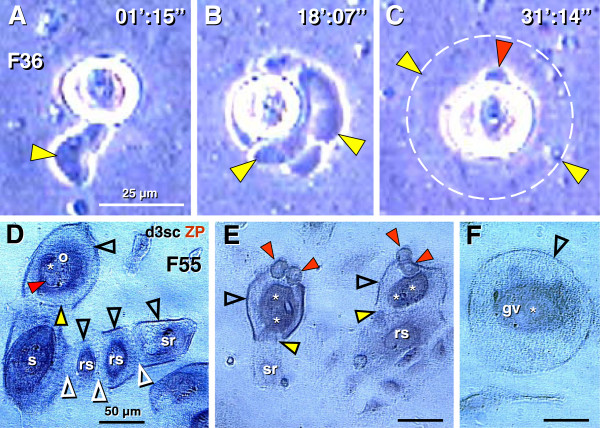
Differentiation of early oocytes and behavior of oocytes in secondary OSC cultures. A-C) Time lapse cinematography of oocyte development in secondary OSC culture. A) Early developing cell with a cytoplasmic tail (arrowhead). B) Multiple cytoplasmic eruptions (arrowheads). C) Development of the 50 micrometers oocyte-like cell (yellow arrowheads indicate cell surface, red arrowhead a polar body). Time in minutes':seconds". Movie segments are available in the Additional file
1, supplemental video S1. D-F) Day 3 secondary OSC culture stained for ZP (d3sc ZP) - 55 year old postmenopausal women three days afer seeding. D) Oocyte (o) with a "chain" of satellite cell (s), regressing satellites (rs), and satelite remnants (sr) interconnected by intercellular bridges (open white arrowheads) and surface ZP expression (open black arrowheads). The "leading" oocyte shows formation of the cell surface in the bridge (solid yellow arrowhead). Asterisk indicates cell nucleus and red arrowhead developing polar body. E) Two "leading" oocyte type cells with surface ZP expression, each of which shows expulsion of two polar bodies (red arrowheads) and retention of two pronuclei (asterisks). Yellow arrowheads indicate a line of separation from remnants of the "satellite" cells lacking surface ZP. F) Large oocyte (140 micrometers) with surface ZP expression (arrowhead), nucleus (asterisk), and germinal vesicle (gv).